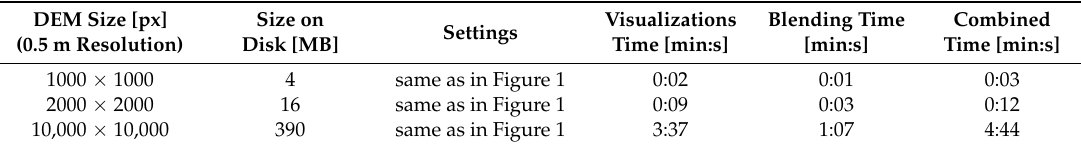
Table 2. Visualization for archaeological topography computation